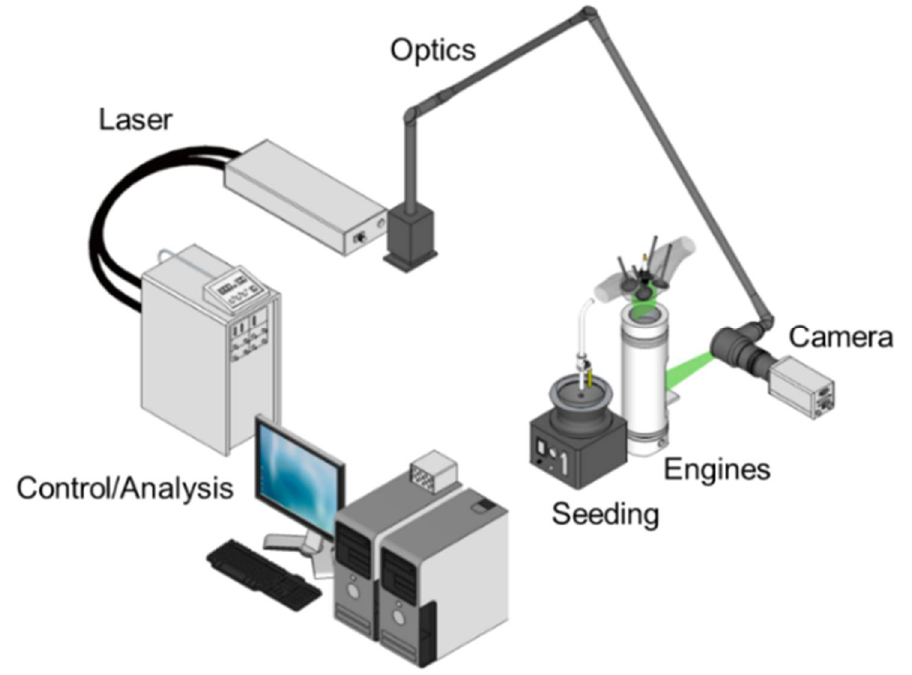
Figure 2. The PIV measurement setup.